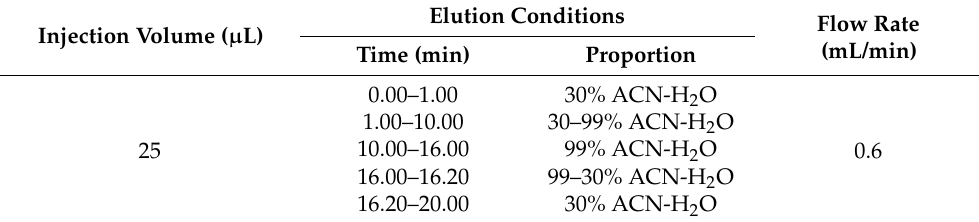
Table 4. Chromatographic analysis